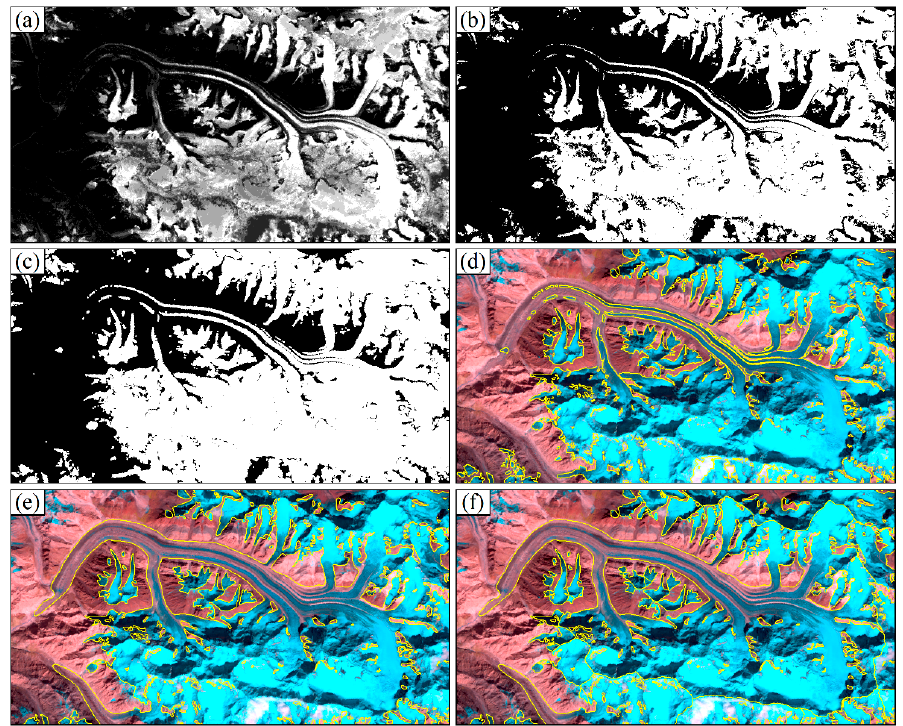
Figure 4. Debris-covered glacier boundary extraction (( a ) Band3/Band5 ratio image, ( b ) image with a threshold of 1.8, ( c ) image after using the median filter, ( d ) glacier outline in vector format, ( e ) image after manual revision, and ( f ) individual glacier outline; ( d – f ) Landsat Thematic Mapper (TM) image (Bands 5, 4, and 3); the image is LT51470312007236IKR00).